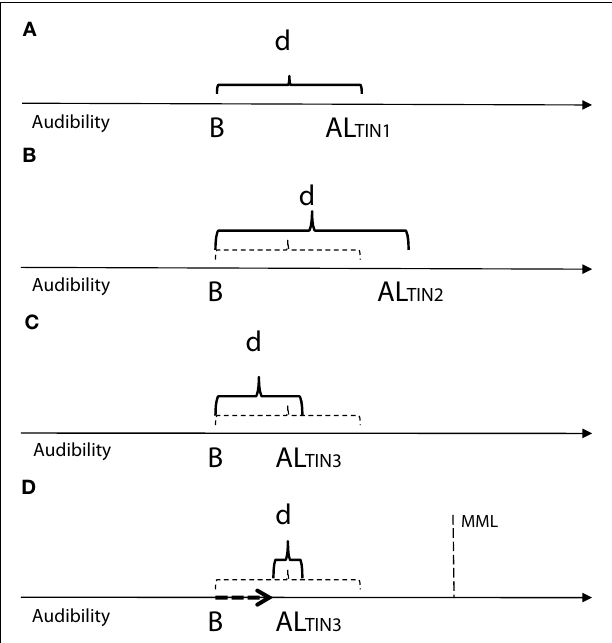
FIGURE 2 |Theoretical relationship illustrating adaptation effects on tinnitus audibility (based on Lauterbach, 1979, Figure 1). “ALTIN” is the adaptation level (center of reference) at a point in time, B represents the level of background sound in the environment ( B < AL), d is the difference between the adaptation level for tinnitus and background sound (contrast). The larger the d value (AL − B ) the better the perceived audibility of tinnitus. (A) Normal level of tinnitus (ALTIN1) for an individual. (B) Adaptation level (ALTIN2) raised due to emotional events, stress, anxiety (ALT’s residual factor). (C) Adaptation level (ALTIN3) reduced due to management of residual factors through counseling or psychological therapy. (D) Same adaptation level (ALTIN3) with raised background sound level (representing sound therapy and counseling); tinnitus audibility d is reduced due the combined effect of a lower adaptation level and reduced contrast.The minimum masking level (MML) is illustrated as an upper theoretical limit to which sound may influence the adaptation level of